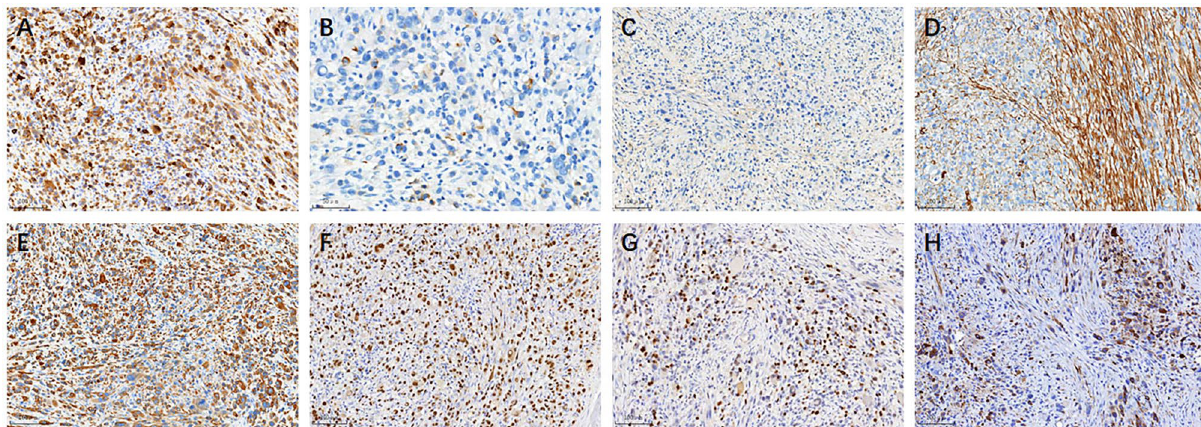
Fig. 2 Immunohistochemical findings of epithelioid and spindle cells rhabdomyosarcoma: Neoplastic cells are remarkably immunoreactive with CK(AE1/ AE3) (Fig. 2A), scattered with CK18 (Fig. 2B), but negative for EMA (Fig. 2C). SMA strongly express in spindle cells but partially in epithelioid cells (Fig. 2D). Noticeably, neoplastic cells strongly and diffusely express the skeletal muscle markers Desmin (Fig. 2E), MyoD1 (Fig. 2F) and Myogenin (Fig. 2G), and par- tially express ALK protein (Fig. 2H). Bar: 50 μm, 200x; 100 μm,